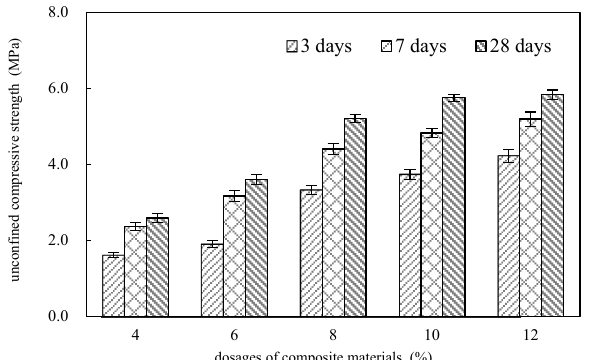
Figure 4. Unconfined compressive strength of solidified red mud at different dosages.